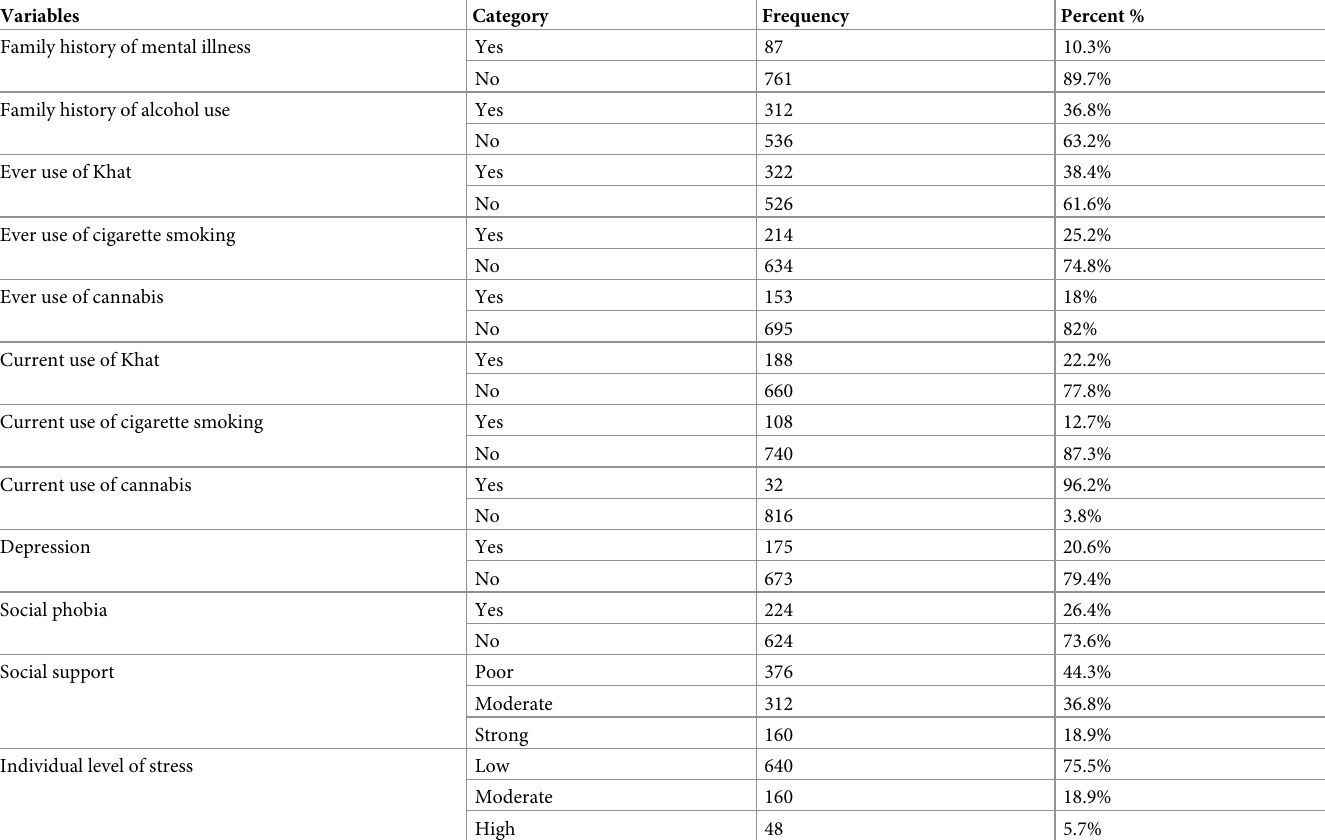
Table 2. Clinical, psychosocial, and substance use characteristics of the participants in south Gondar zone, northwest Ethiopia, 2020 (n = 848). Variables